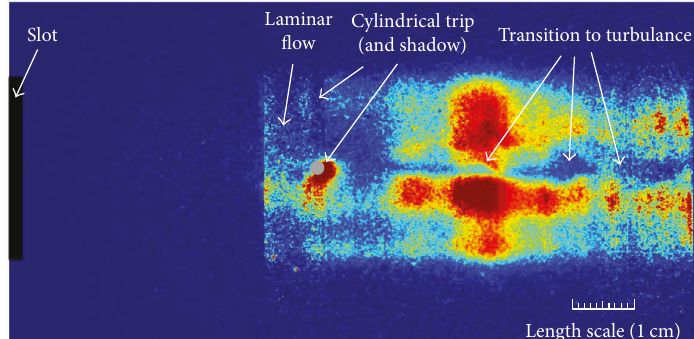
Figure 5: The typical 100Hz acetone PLIF image. The diameter=2 mm; the distance between the cylinder and the slot was 5.9cm; the distance between fl at and laser sheet was 3mm; Reynolds number =800; and frame rate =500 Hz.